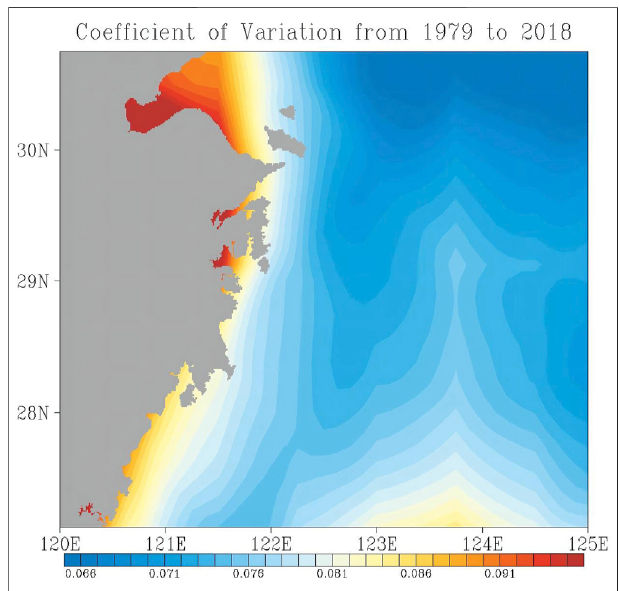
FIGURE 8 | Multi-year averaged coef fi cient of variation of the wind power